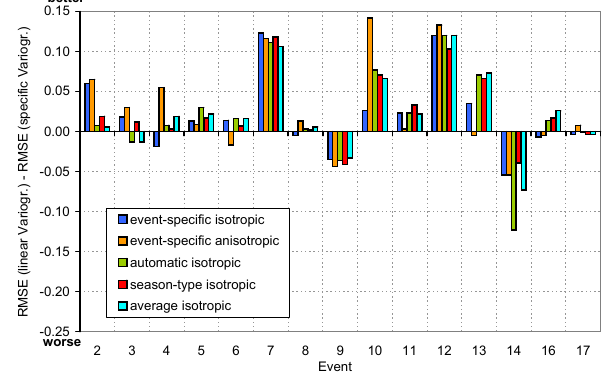
Fig. 4. RMSE difference between the selected variogram type and an “assumed linear” variogram, averaged over time steps with mean precipitation intensity exceeding a threshold of 1.0mmh − 1 . OK is used for interpolation.